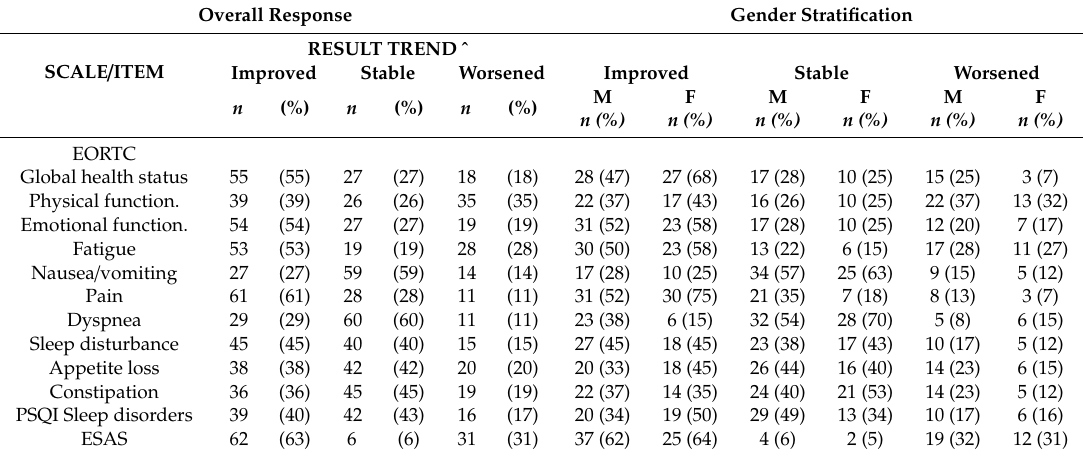
Table 4. Best quality of life response: overall data ( A ) and gender stratification ( B ).